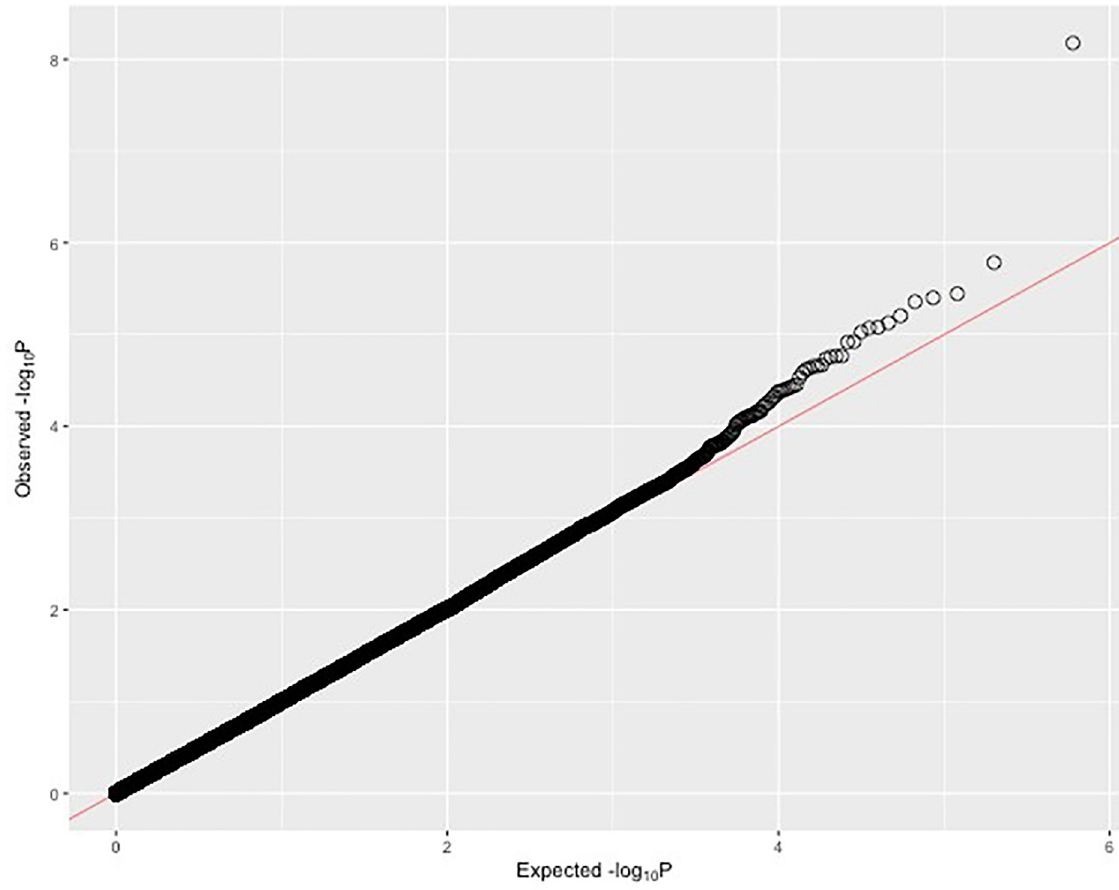
Fig 2. Q-Q plot of results from adjusted GWA analysis: For each point, y-axis is the observed–log 10 p -value of association from a model adjusted for biological variables. X-axis is the expected–log 10 p -value under the null hypothesis. The line represents same expected and observed p -value for every SNP. Deviations above the line show observed p -values higher than expected.